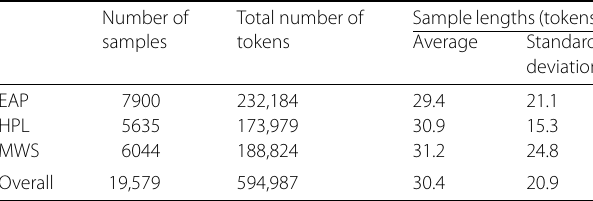
Table 3 Overview of the Spooky Books Data Set